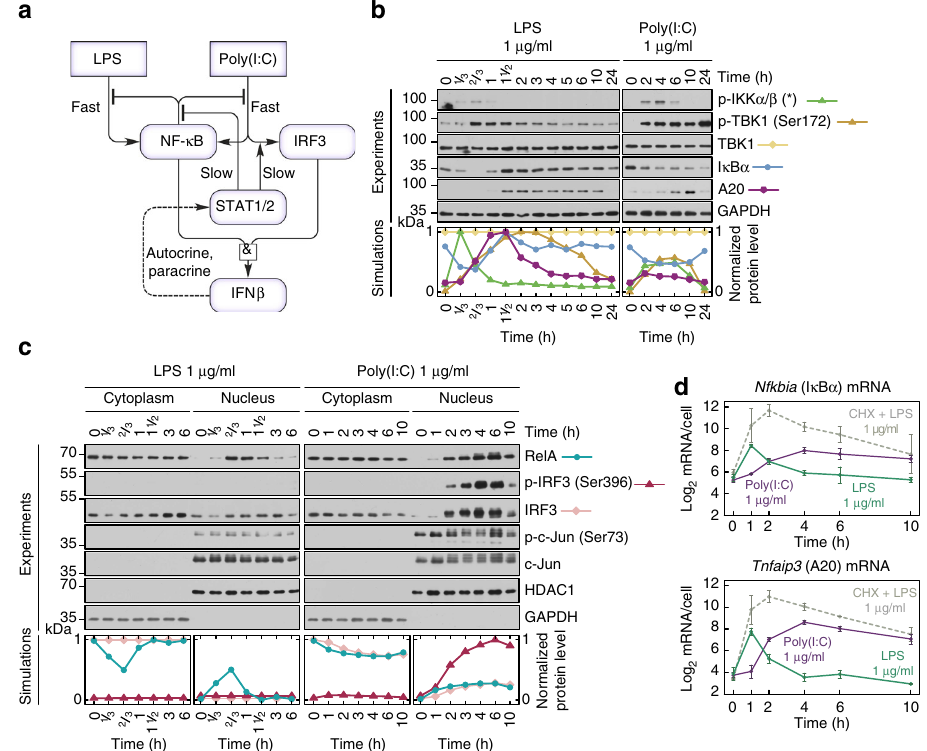
Fig. 1 LPS and poly(I:C) elicit divergent responses. a Schematic diagram of the regulatory system of three transcription factors, NF- κ B, IRF3 and STAT1/2, activated upon stimulation with LPS or poly(I:C). The synthesis of cytokine IFN β , mediating autocrine and paracrine signalling, requires activation of both NF- κ B and IRF3. Arrow heads = activation, hammer heads = inhibition. b , c Protein levels of the system components in response to LPS or poly(I:C), characterised by western blotting and compared with numerical model simulations. WT MEFs were stimulated with 1 μ g/ml LPS or 1 μ g/ml poly(I:C). GAPDH and HDAC1 serve as loading controls. Trajectories show averages of 200 independent stochastic simulations; the colour key is located next to protein labels. b Whole-cell extracts were analysed using antibodies against phosphorylated (active) forms of IKK α / β and TBK1, as well as total TBK1, I κ B α and A20. Representative experiments out of 2 for LPS and 4 for poly(I:C) are shown. (*) = IKK isoform-dependent phosphorylation sites: p-IKK α Ser176/ 180, p-IKK β Ser177/181. c Cytoplasmic and nuclear fractions were analysed using antibodies against total RelA (NF- κ B), IRF3 and c-Jun, as well as